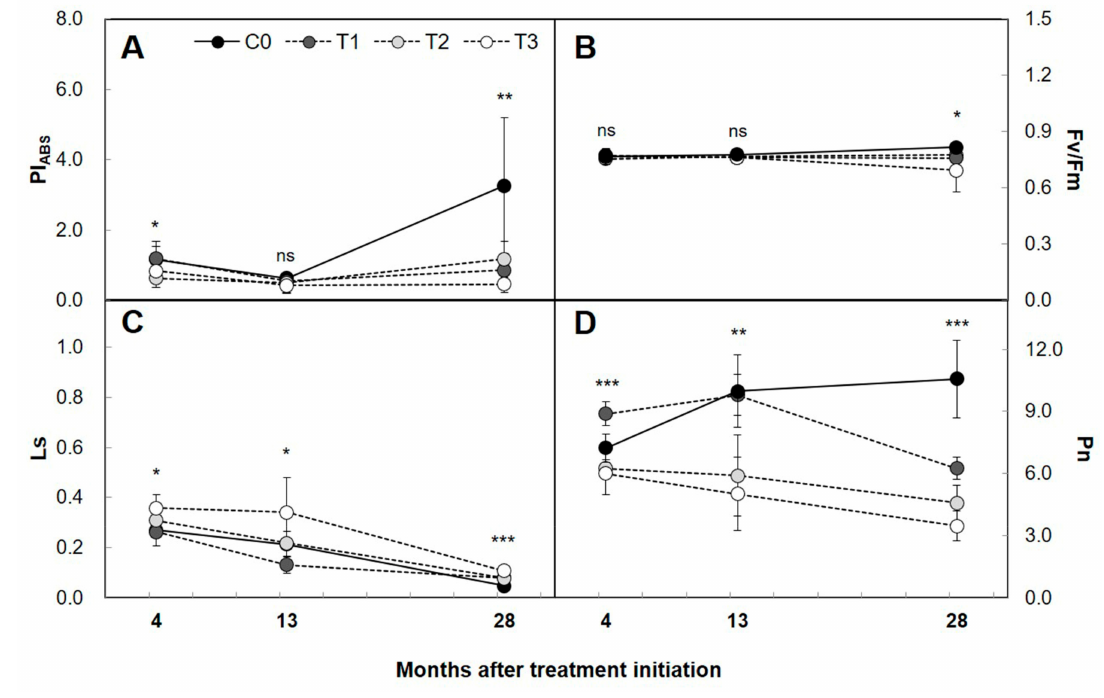
Figure 3. Seasonal changes of photosynthetic function in yellow-poplar leaves treated with artificial night lighting. ( A ) Performance index (potential) for energy conservation from photons absorbed by PSII antenna to the reduction of Q B (PI ABS ); ( B ) fluorescence-based maximum quantum yield of photosystem II photochemistry (Fv/Fm); ( C ) stomatal limitation to photosynthesis (L S = 1 − Ci/Ca); ( D ) photosynthetic rate (Pn, µ mol · m − 2 · s − 1 ) of yellow-poplar plants exposed to the natural day/night cycle (C0) and the day/night with artificial lighting cycle (T1, T2, and T3) during the experimental period. The black solid circles ( ), gray solid circles ( ), light gray solid circles ( ), and hollow circles ) represent C0, T1, T2, and T3, respectively. The x -axis represents the months after treatment initiation (cid:35) at 1 May 2013. Data points represent mean ± SD of five experimental replicates. Asterisks represent significant treatment effects at a single measuring date (* p < 0.05; ** p < 0.01; *** p < 0.001; ns, not